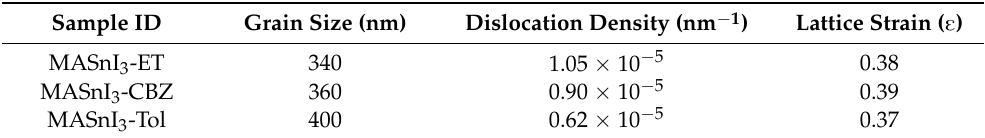
Table 1. Parameters of XRD spectra of MASnI 3 films treated with toluene, chlorobenzene, and diethyl